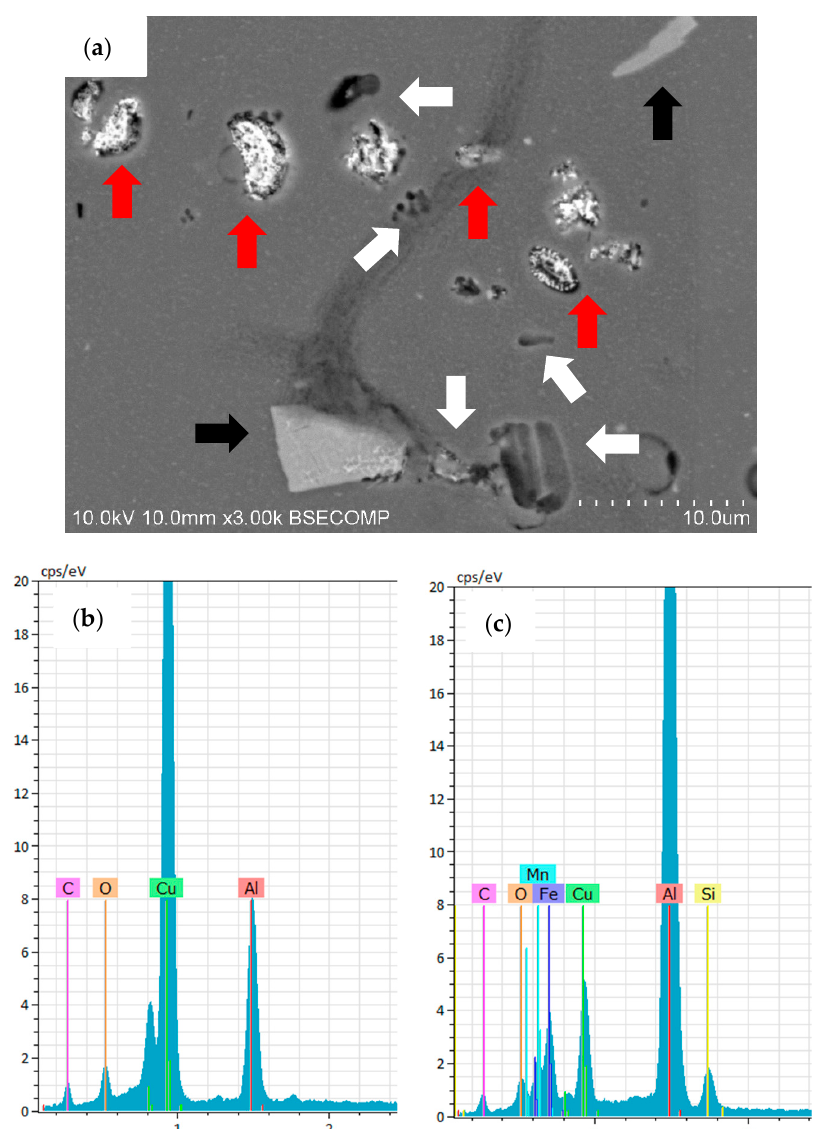
Figure 4. ( a ) SEM image of the main phases identified in alloy AA2024-T3 after Pretreatment 2; ( b ) EDX spectrum of sponge-like Al(Cu,Mg) particle (white arrows); ( c ) EDX spectrum of Al-Cu-Fe-Mn-(Si) particle (black arrows).